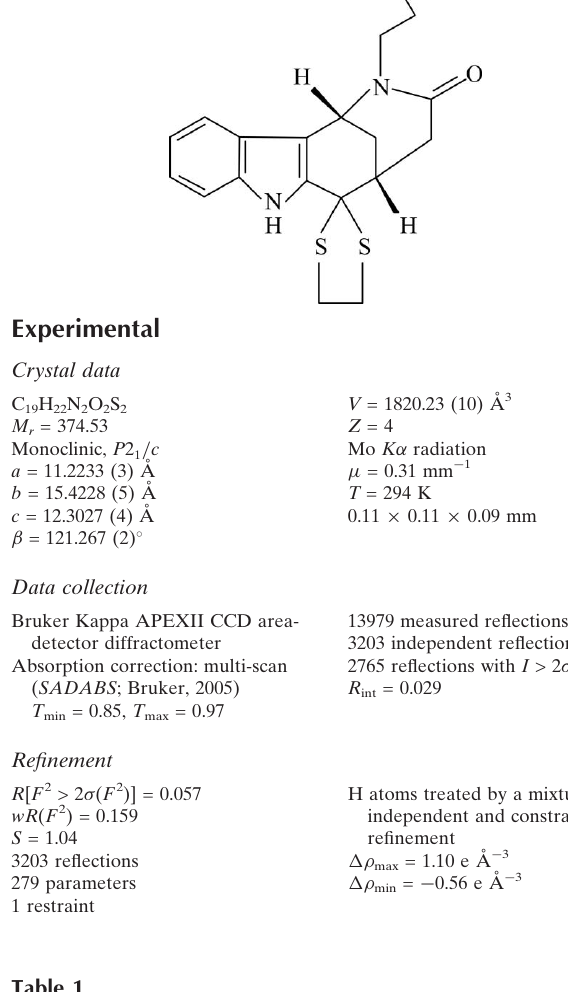
Hydrogen-bond geometry (A˚ , (cid:2)